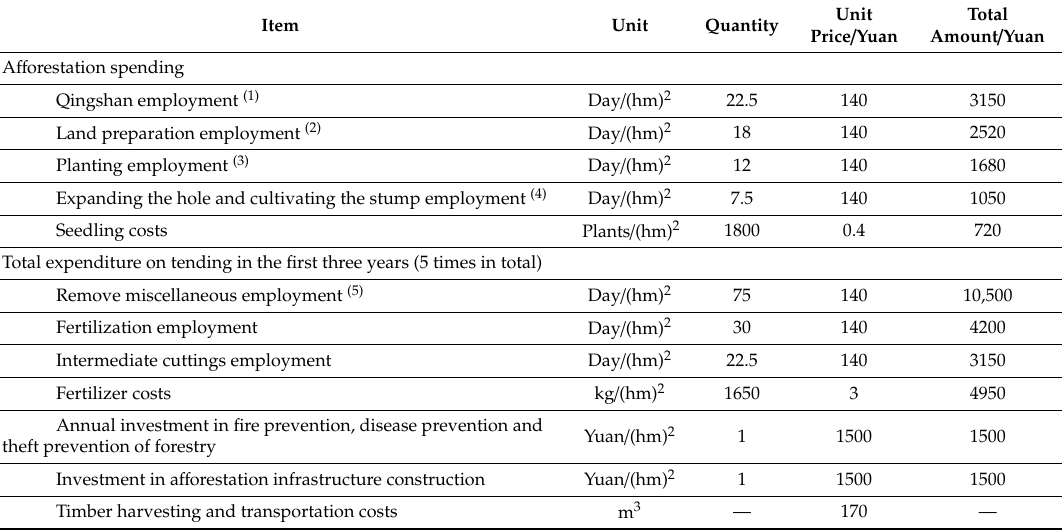
Table 1. The costs of the P. elliottii a ff orestation project for carbon sink per unit area (hm) 2 . Item Unit